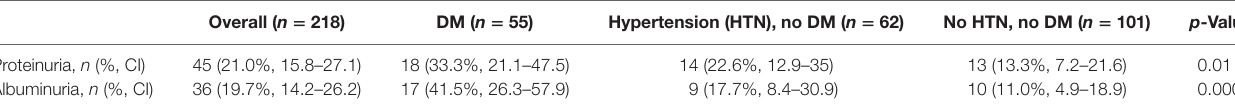
Table 2 | Prevalence of proteinuria and albuminuria in each patient